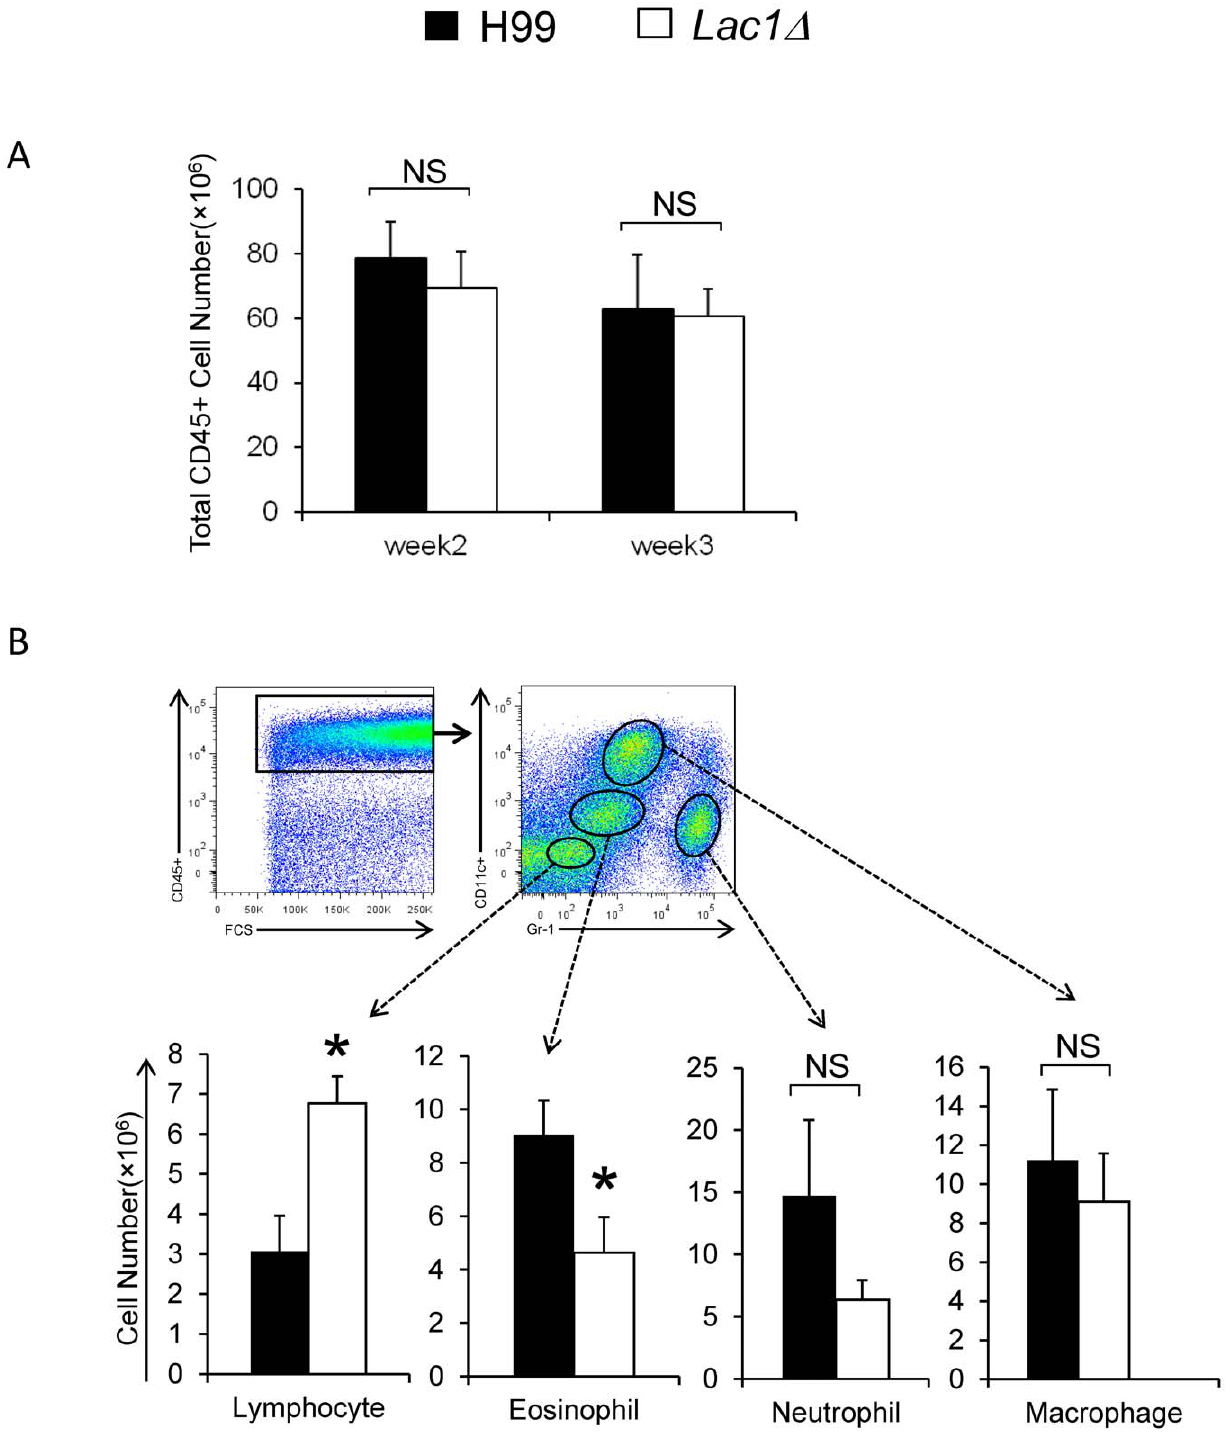
Figure 2. Effect of cryptococcal laccase on the recruitment of total lung leukocytes and leukocyte subsets. Lung leukocytes were isolated from mice infected with H99 or lac1 D , antibody, stained and analyzed using flow cytometric analysis as per Materials and Methods. The total number of CD45 + leukocytes was determined by multiplying the frequency of CD45 + by total number cells at 2 and 3 wpi (A); Representative FACS plots show the staining strategy to isolate lung leukocyte subsets within gated populations of CD45 + leukocytess. Macrophage, Eosinophil, Neutrophil, and Lymphocyte subsets were identified based on the expression of Gr-1 vs CD11c. Total numbers of Macrophages, Eosinophils, Neutrophils, and Lymphocytse were determined by multiplying the frequency of each subset by the total number of CD45 + leukocytes at 3 wpi (B). Bars represent data (mean 6 SEM) from 2–3 separate matched experiments, N =6 and above for each of the analyzed parameters; *p , 0.05 in comparison between wt and mutant; NS, no significant difference between wt and mutant.